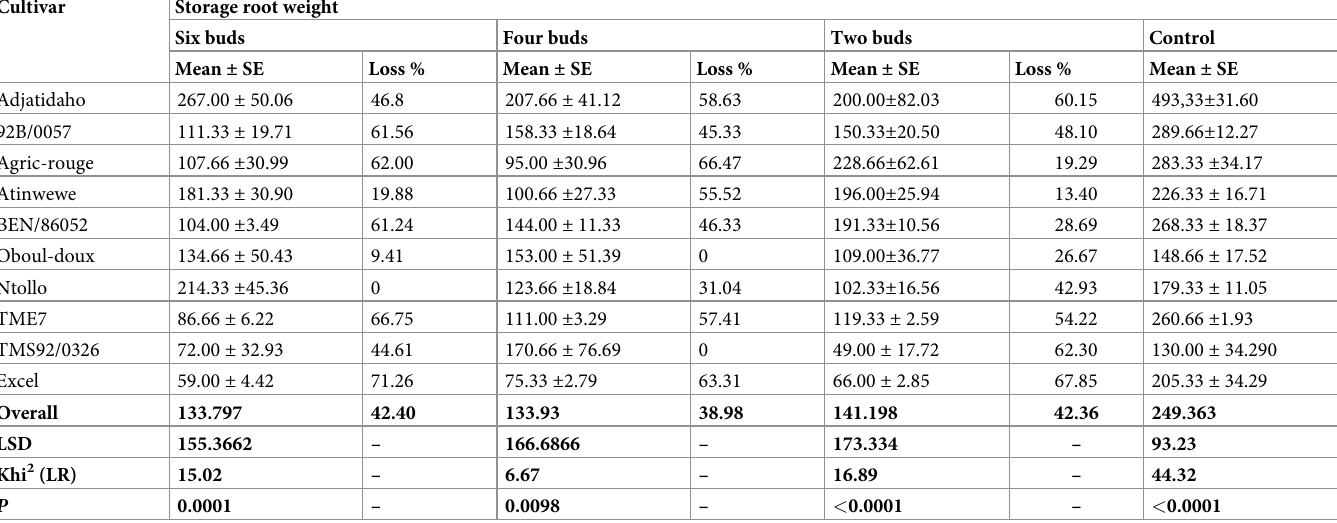
There were differences in storage root weight among cultivars inoculated with two, four, and six buds (P < 0.05) (S3 Table), with storage root weight tending to be lower than in the non-inoculated controls (Table 5). In the six-bud treatment, the greatest storage root weight was for ‘Adjatidaho’ and lowest for ‘Excel’. Overall, the greatest relative loss in root weight was for ‘Excel’ and lowest for ‘Ntollo’. Effects on storage root weights were similar in the four- and six-bud treatments, with the greatest relative loss recorded for ‘Agric-rouge’ and no effect for ‘Oboul-doux’ or ‘TMS92/0326’. In the two-bud treatment, the greatest storage root weight was for ‘Adjatidaho’ and lowest for ‘TMS92/0326’, and the greatest relative loss in storage root weight was for ‘Excel’ and the lowest was for ‘Atinwewe’. Table 5. Effect of viral dose (number of buds inoculated) on cassava storage root weight. Cultivar Storage root weight Six buds Four buds Two buds